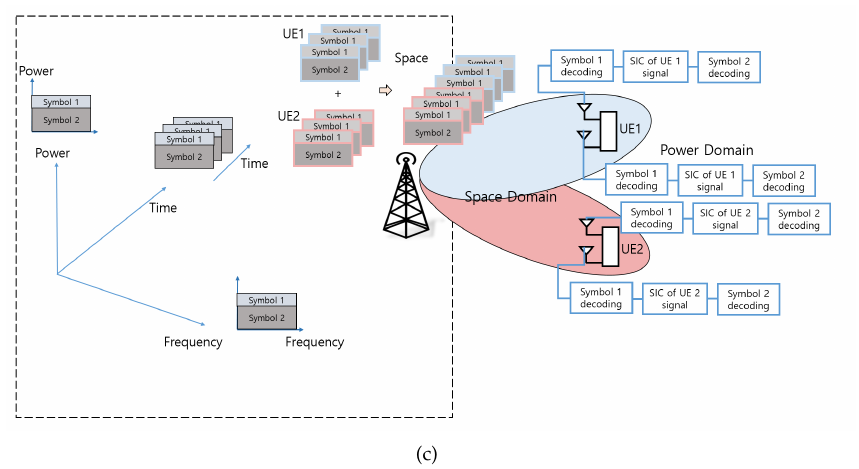
Figure 1. Examples of resource usage in various dimensions ( a ) Example of resource usage for conventional NOMA; ( b ) Example of resource usage for conventional BD; ( c ) Example of resource usage for proposed scheme.